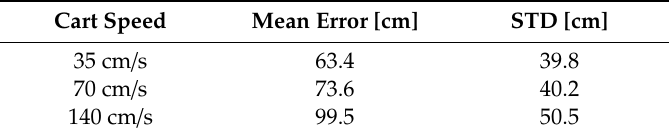
Table 3. Localization errors obtained in the simulation. Along with this paper, we provide a Supplementary Video File which thoroughly demonstrates error calculation in E4.